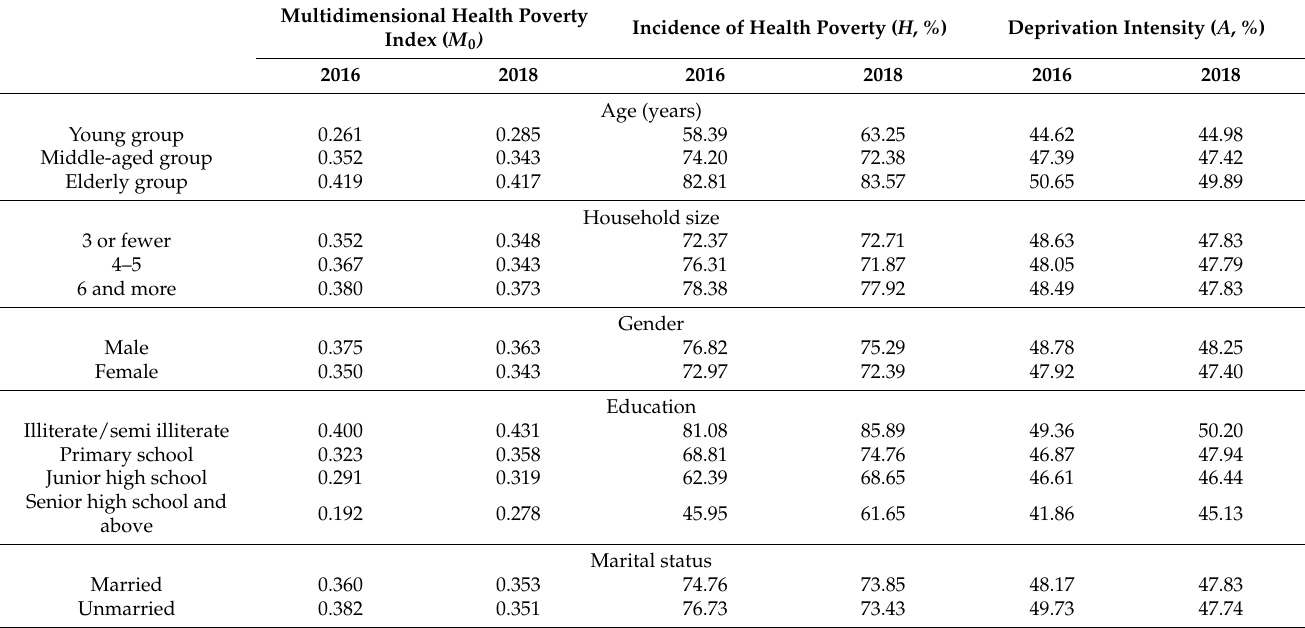
Table 5. Heterogeneity analysis of multidimensional health poverty index at K = 0.3. Multidimensional Health Poverty Index ( M 0